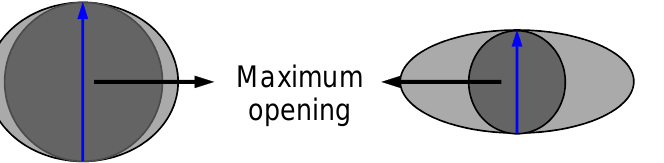
Figure 2. Schematic diagram showing two different pores and the spheres (dark grey) used to evaluate the maximum opening (blue arrow).